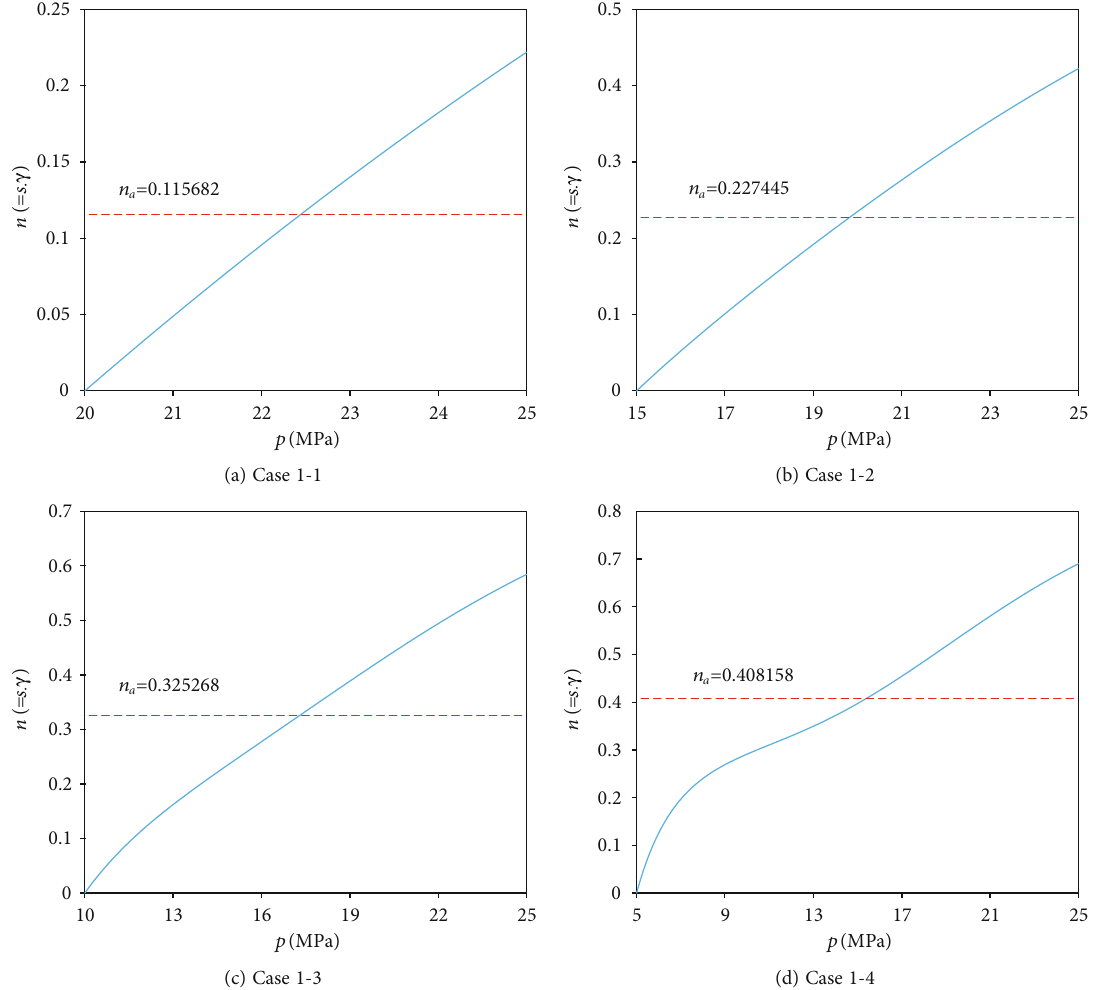
Figure 33: Instantaneous decline exponent n vs. p for the simulated gas reservoir with normal